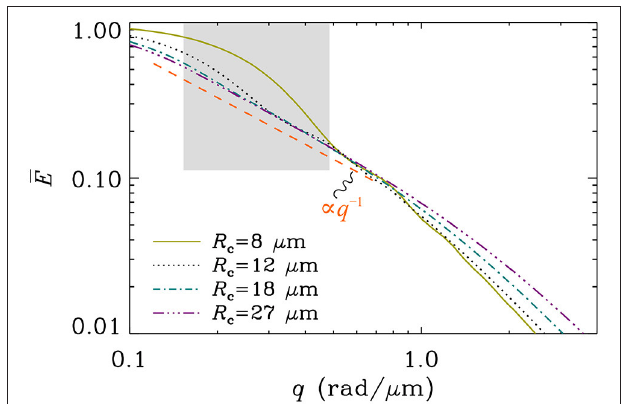
FIGURE 4 | Simulation of the orientationally averaged signal for diffusion along an arc of various curvature radii. The contour length was taken to be infinite so that the results for Regime A are employed. The timing parameters were taken to be clinically realistic for high b -value acquisitions ( δ 1 60 ms), and the diffusion coefficient was set to D = box depicts roughly the range of b -values between 1 and 10 ms / µ m 2 . It is seen that the larger the curvature radius, the wider the range over which the exponent 1 can be observed. Conversely, below a cutoff determined by the − averaging length √ D δ , a steeper decay of the signal becomes very